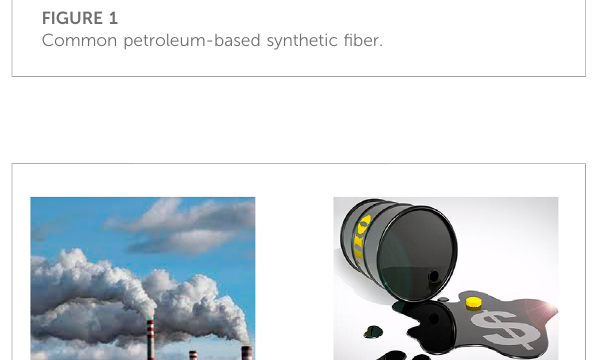
FIGURE 1 Common petroleum-based synthetic fi